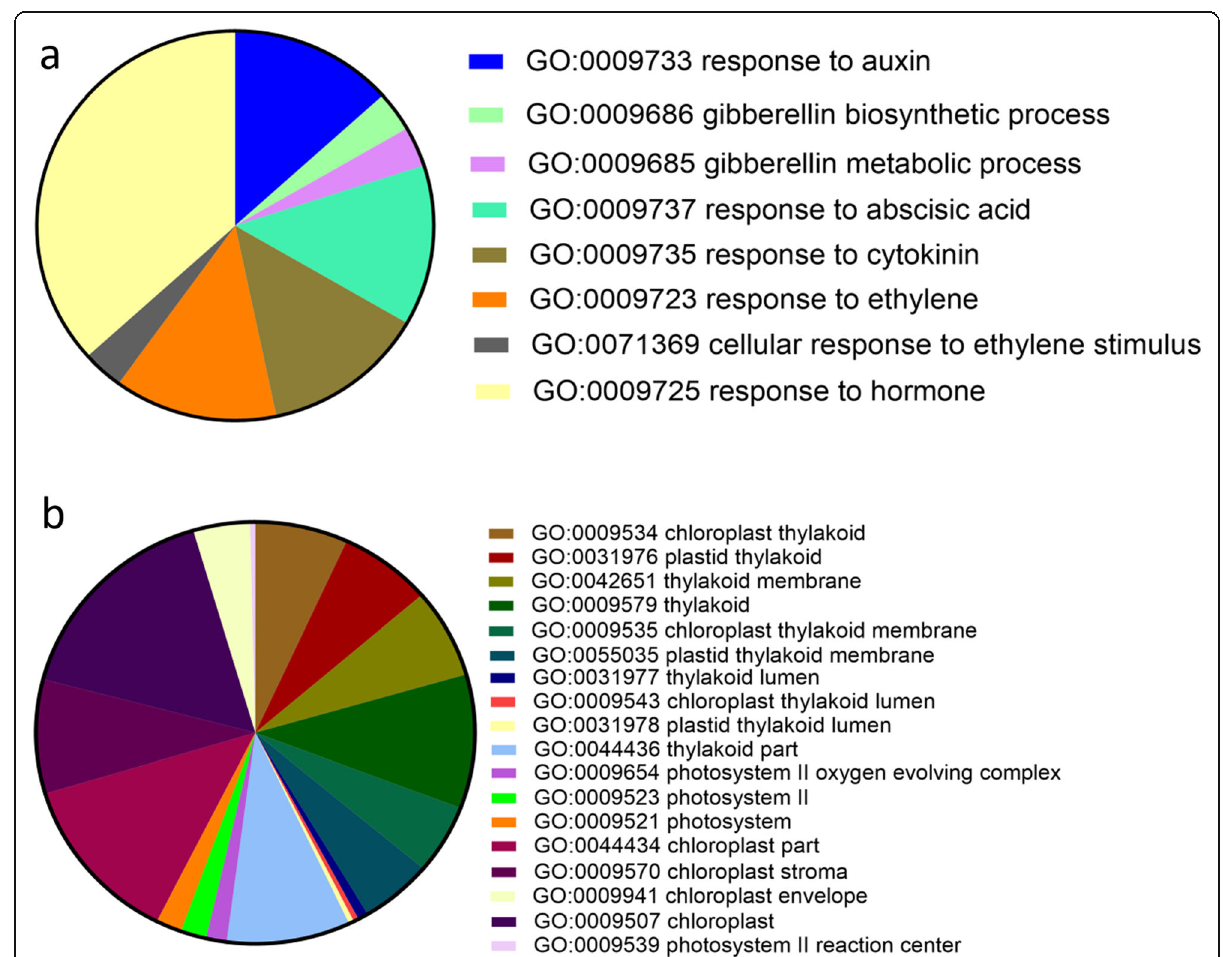
Fig. 3 Gene ontology (GO) analysis of differentially expressed genes related to metabolism and signaling pathways of phytohormone and photosynthesis in response to wheat dwarf virus (WDV) infection in wheat ( Triticum aestivum ). a Gene ontology (GO) analysis of differentially expressed genes related to phytohormone metabolism and signaling pathways. b Gene ontology (GO) analysis of differentially expressed genes related to photosynthesis related